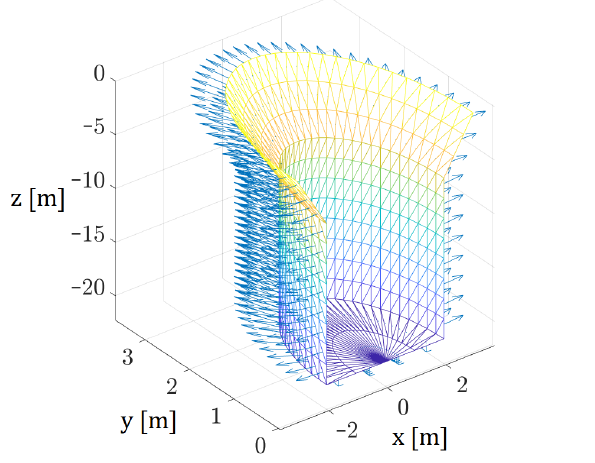
Figure 5. The mesh for NEMOH, which considers the buoy fixed at one position and only discretises the surface area of the buoy beneath the still water level ( z ≤ 0) into panels. The excitation amplitude and phase were calculated for ω ∈ [ 0.05, 2.4 ] [rad/s] with a step size of δω = 0.05 [rad/s] and at 11 different buoy submergence levels where the position of the buoy is vertically translated by z ∈ {− 5, − 4, − 3, − 2, − 1, 0, 1, 2, 3, 4, 5 } [m]. Figure 6 illustrates the parameters of the wave excitation force ( f e ( z , ω ) , θ e ( z , ω )) for the test case buoy.